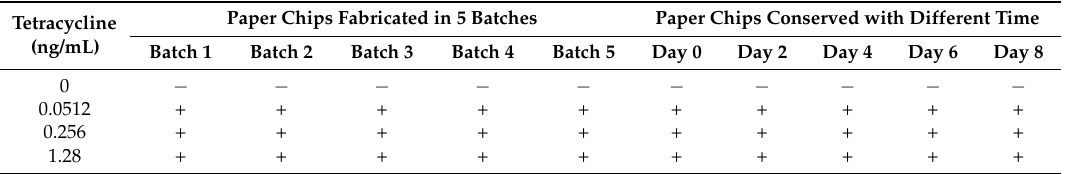
Table 2. Stability testing of the fabricated paper